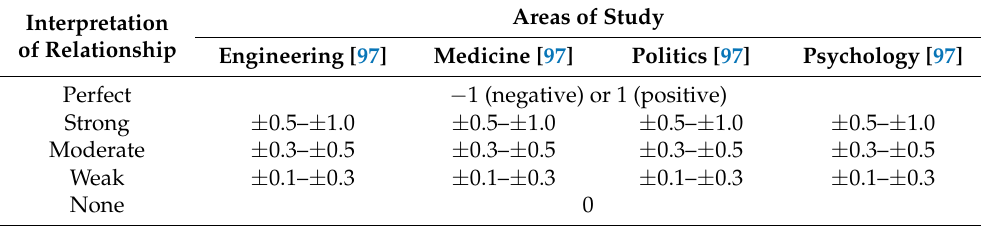
Table 2. The interpretation of PCC’s value in engineering, medicine, politics and psychology